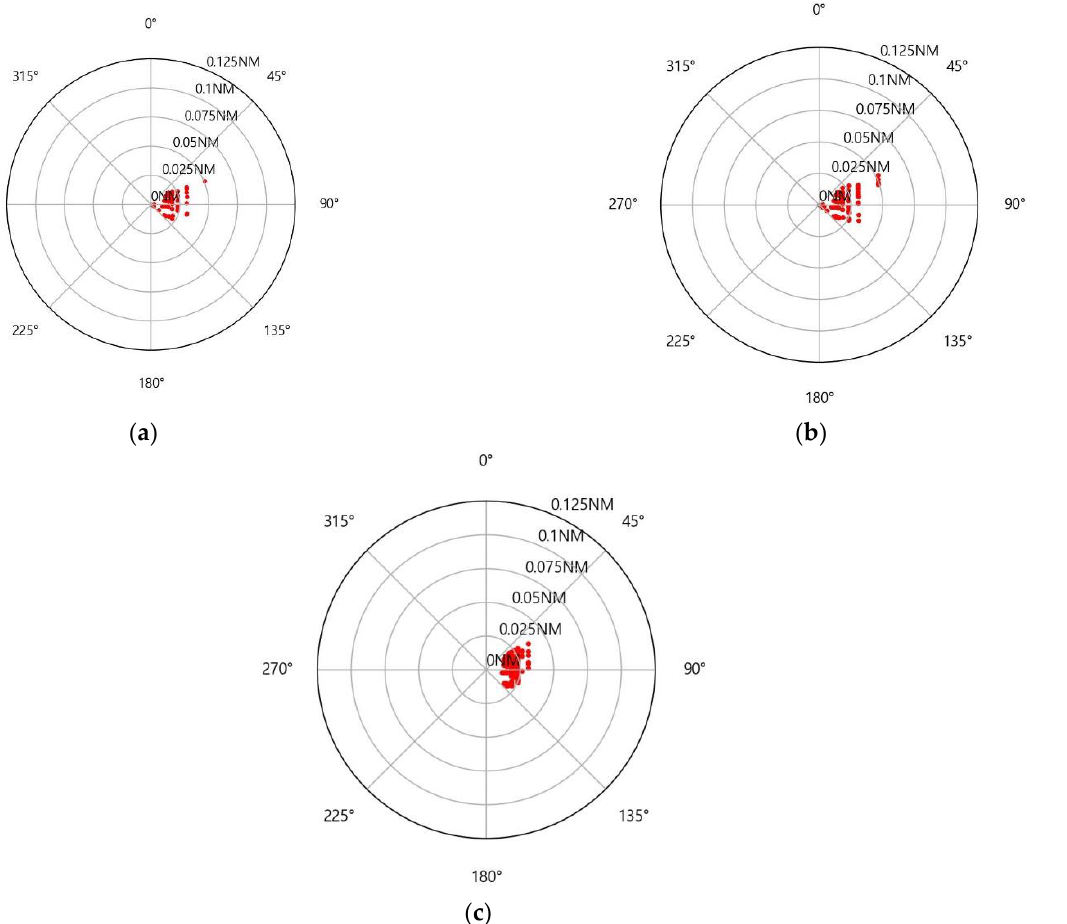
Figure 24. Visualization of distance calculation results by stereo vision (Experiment B): ( a ) SSD, ( b ) NCC, and ( c ) ORB.